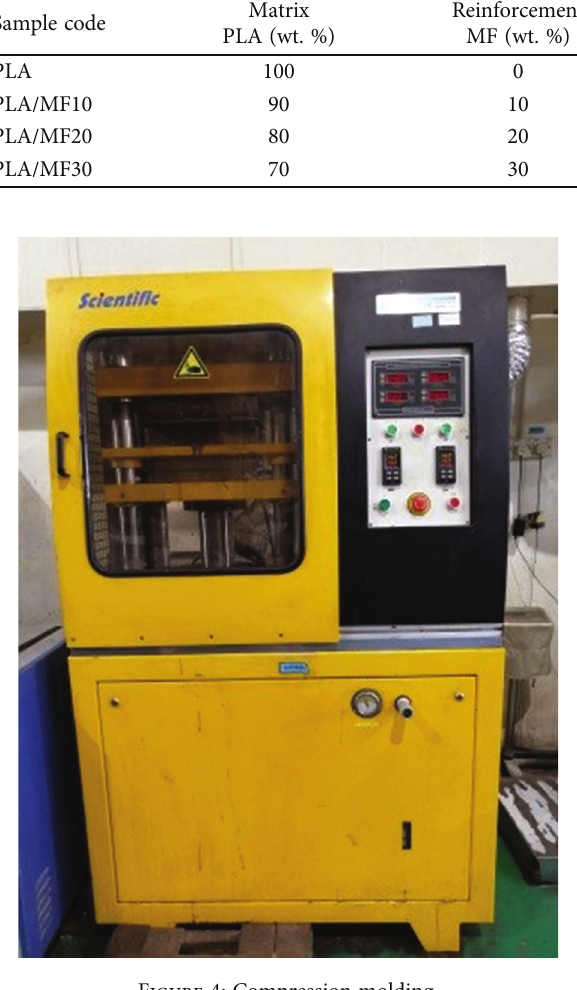
Figure 4: Compression molding. Table 2: Properties of PLA/MF composites